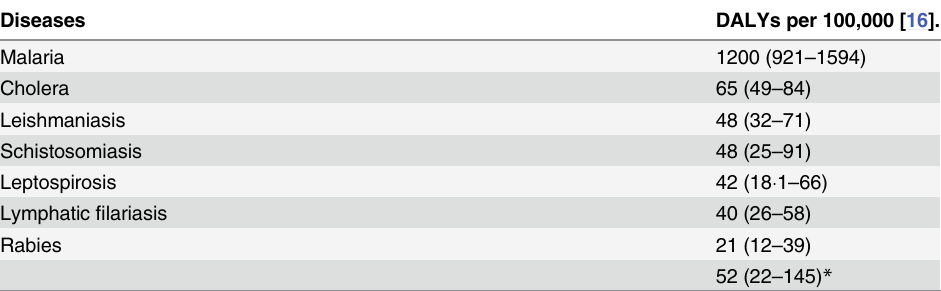
Table 5. The burden of leptopirosis per 100,000 compared to GBD estimates for the burden of various tropical and neglected diseases. Diseases DALYs per 100,000